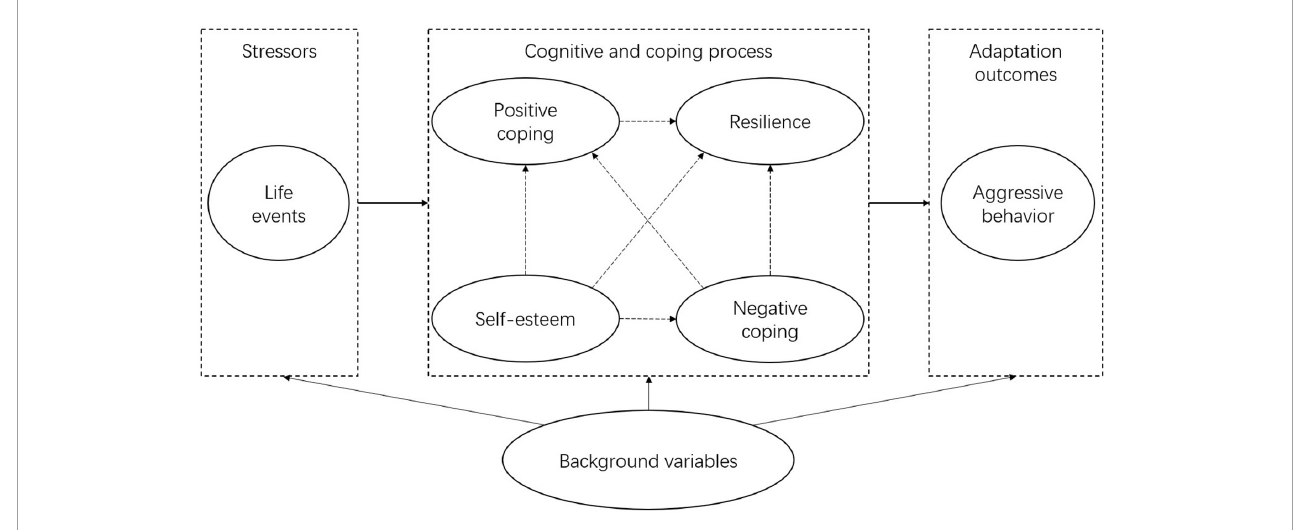
FIGURE1 Hypothetical model A.